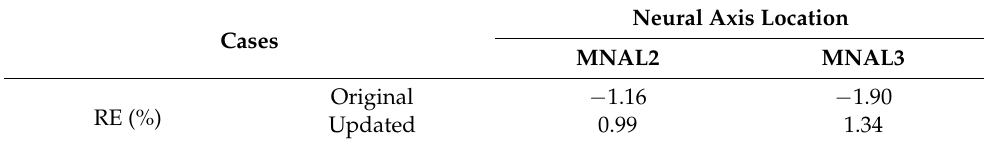
Table 10. Defined error indices for the updated model under the prestressing force of 62 kN. Neural Axis Location Cases Original